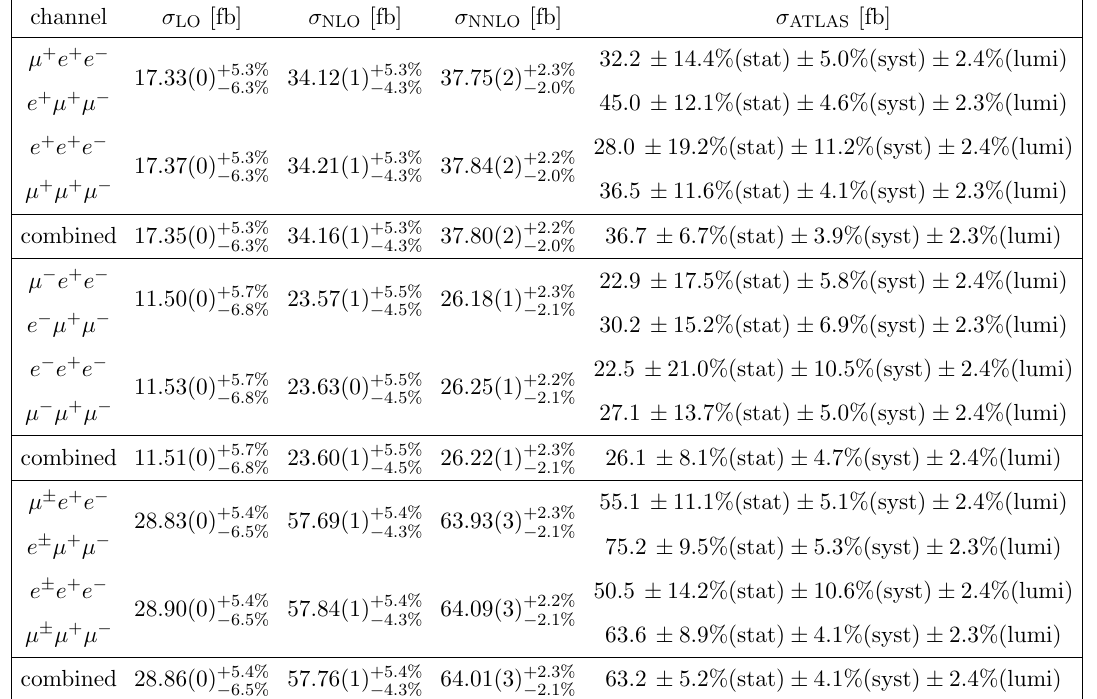
Table 3 . Fiducial cross sections for ATLAS 13 TeV. Note that due to the (cid:13)avour-unspeci(cid:12)c lepton cuts the theoretical predictions are (cid:13)avour-blind, which is why the results are symmetric under e (cid:22) exchange. The available ATLAS data from ref. [7] are also shown. \Combined" refers to the $ average of di(cid:11)erent lepton channels.